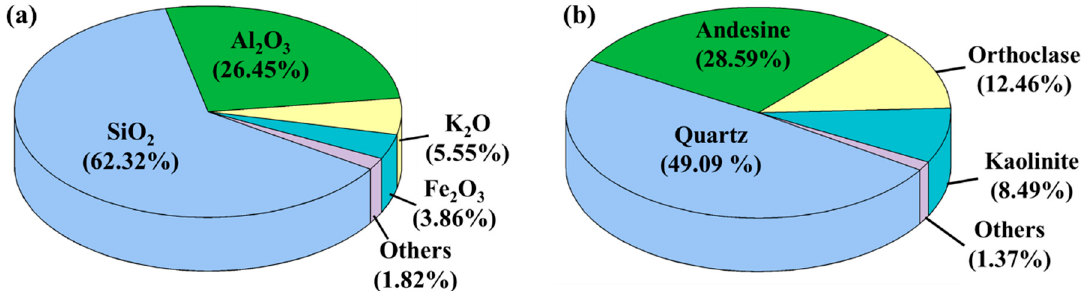
Figure 1. ( a ) Major oxides and ( b ) major minerals composition of rock (wt. %).